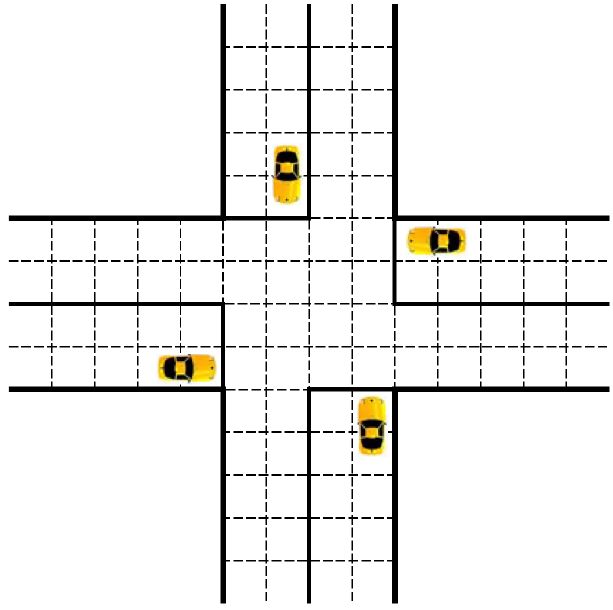
Figure 2. A four-way intersection discretized into a grid of